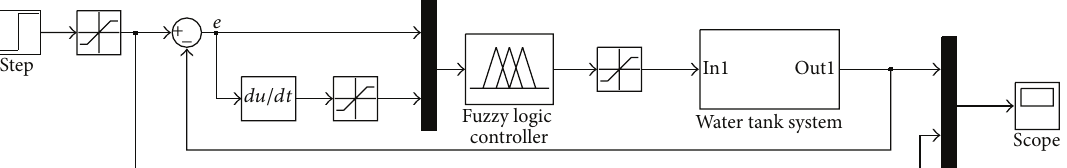
Figure 4: Simulation of the control system.